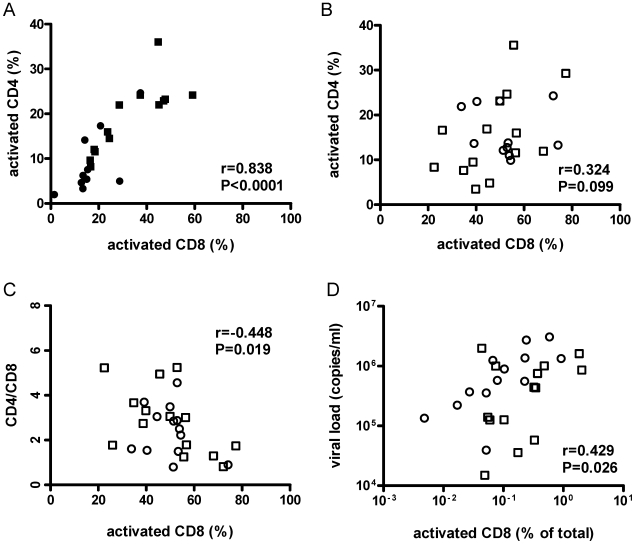
Activation of CD8+ cells was associated with lower CD4+/CD8+ cell ratios and higher viral loads.Human CD8+ splenocyte activation levels defined by HLA−DR+ and CD38+ co-staining from HIV−/DSS− (black circle), HIV−/DSS+ (black square), HIV+/DSS− (white circle), and HIV+/DSS+ animals (white square) were correlated with CD4+ cell-activation levels, CD4+/CD8+ cell ratio, and viral load. (A) In uninfected mice, activation levels of CD8+ and CD4+ cells were tightly correlated (n = 23, pooled data from two independent experiments). (B) But in HIV+ mice, this relationship was not as clear (n = 27, pooled data from two independent experiments). (C) In HIV+ mice, higher percentages of activated CD8+ cells correlated with lower CD4+/CD8+ cell ratios. (D) When activation levels were adjusted for overall engraftment by calculating percentages of HLA-DR+CD38+CD8+ cells of total cells, including murine cells, CD8+ cell activation correlated also with higher viral loads.